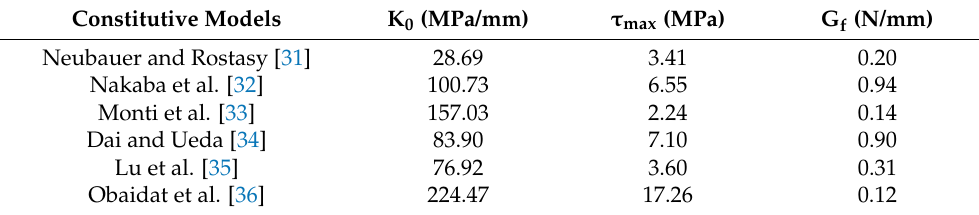
Table 6. Calculation of characteristic parameters of the traction–separation